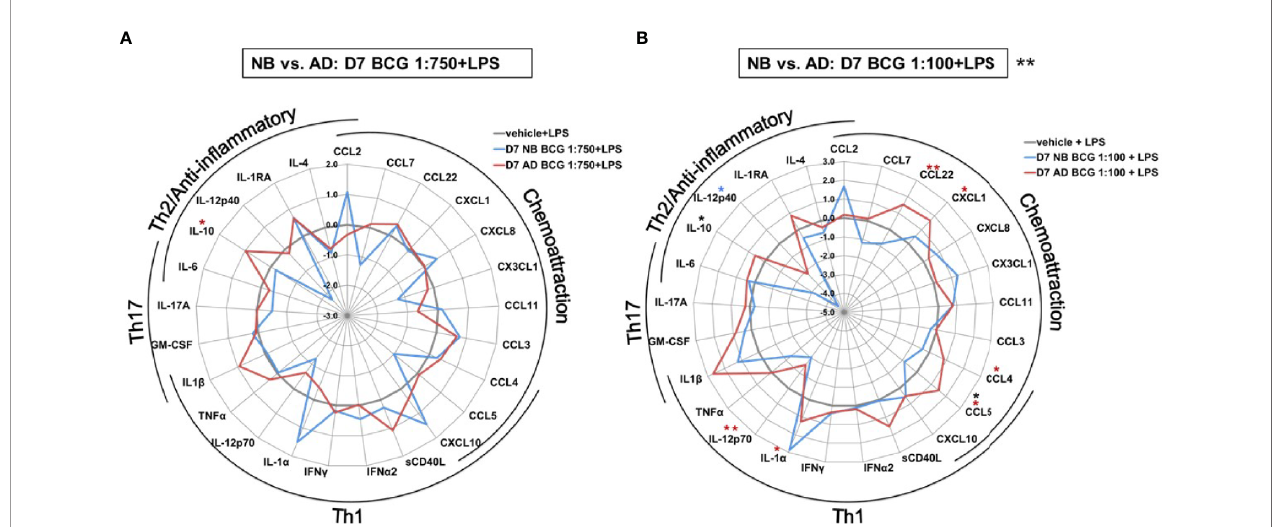
FIGURE 5 | Distinct LPS-induced cytokine production by BCG-trained human newborn vs. adult monocytes at Day 7 of culture. Human newborn and adult CD33+ monocytes were cultured in vitro as described in Figure 1 . Cytokines and chemokines were measured by Multiplex assay. Data shown for BCG concentrations (A) 1:750 vol/vol and (B) 1:100 vol/vol. Data was normalized to RPMI control, log 2 transformed, and represents log 2 fold-change. N = 5 newborns and 7 adults; * p < 0.05; **p < 0.01 (blue stars: NB vs. vehicle; red stars: AD vs. vehicle; black stars: NB vs. AD). Vehicle-(re)stimulated conditions shown in